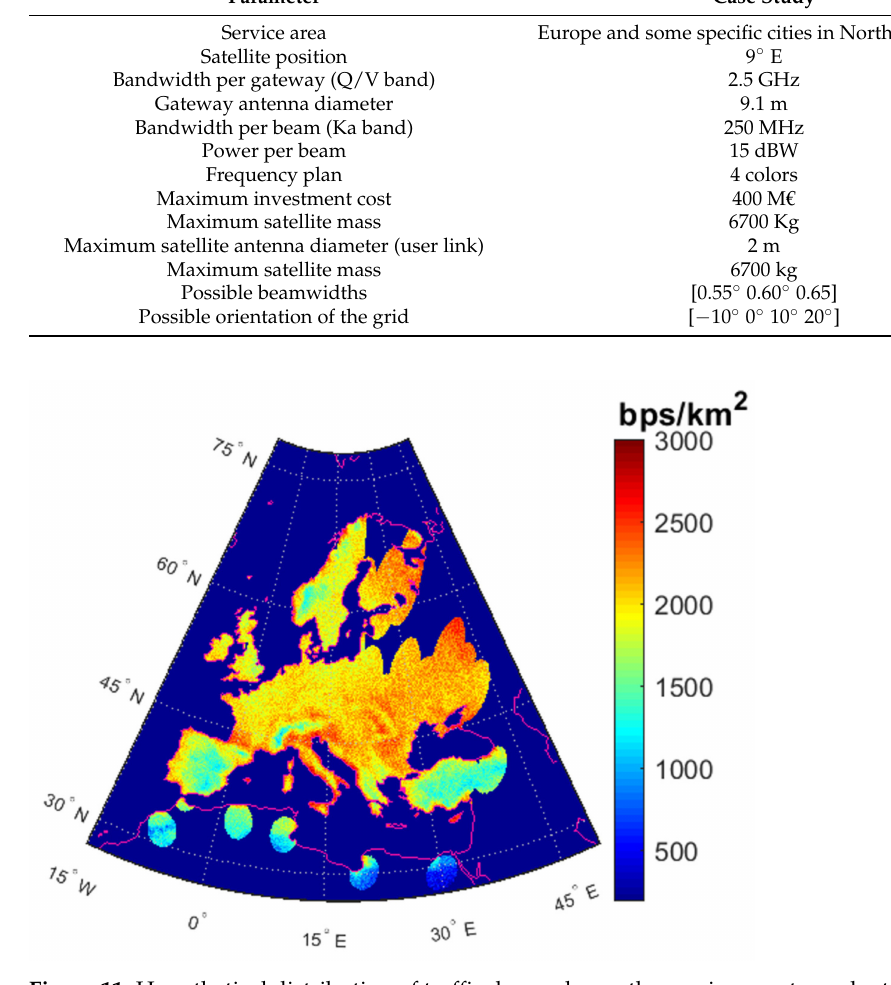
Figure 11. Hypothetical distribution of traffic demand over the service area to evaluate the perfor- mance of the